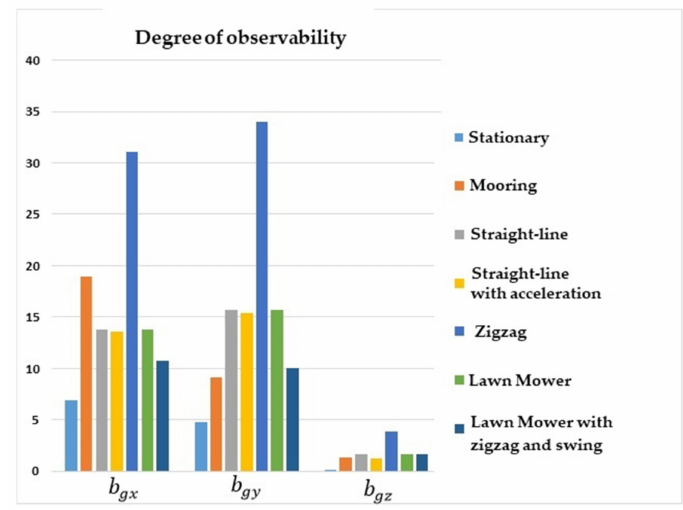
Figure 10. Degrees of observability of the gyro biases. INS/DVL integration.